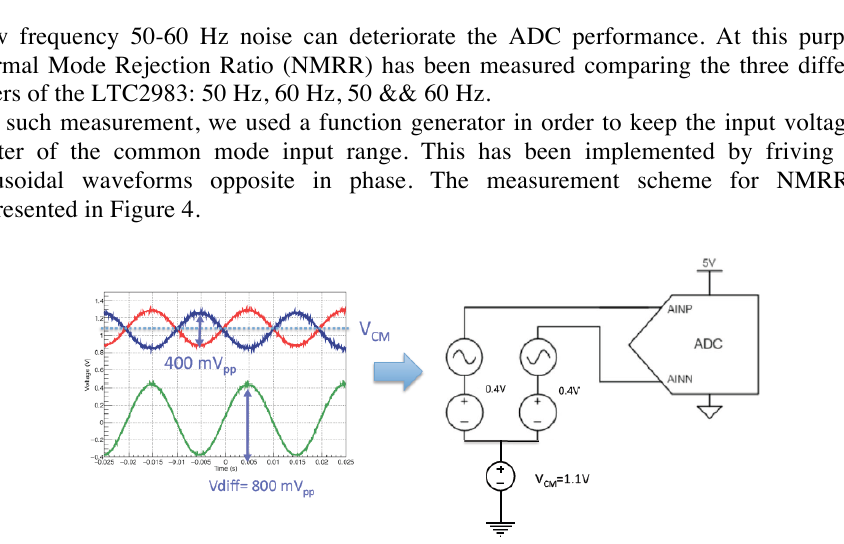
Figure 2. The T-Rh controller based on LTC2983 System-On-Chip.